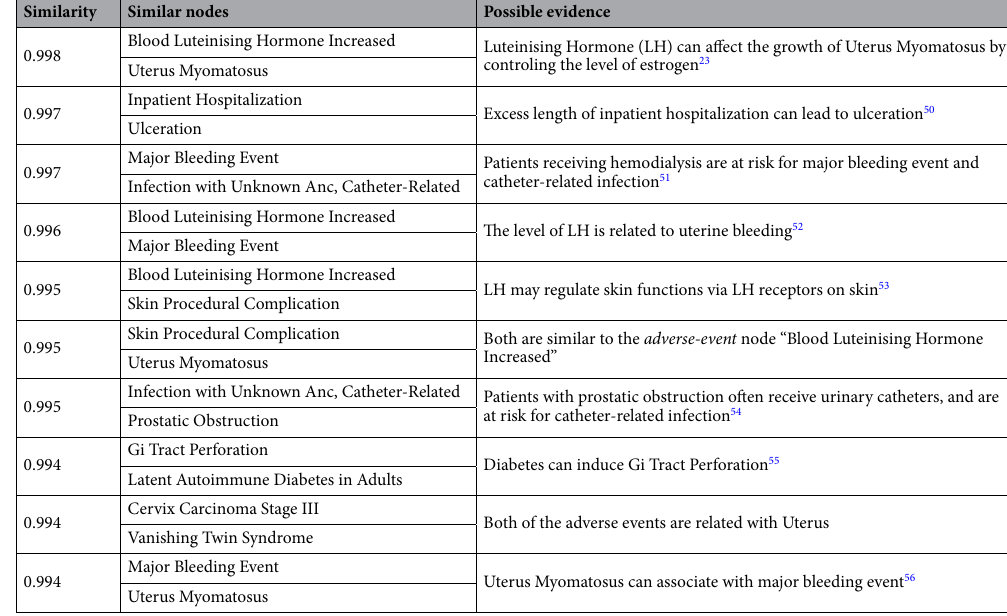
Table 7. Top-10 most similar adverse-event nodes. The average cosine similarity among adverse-event nodes is 0.329.